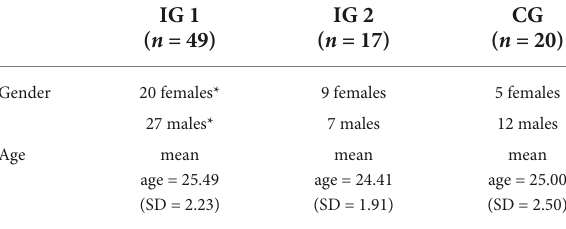
TABLE 1 Overview of the study population at